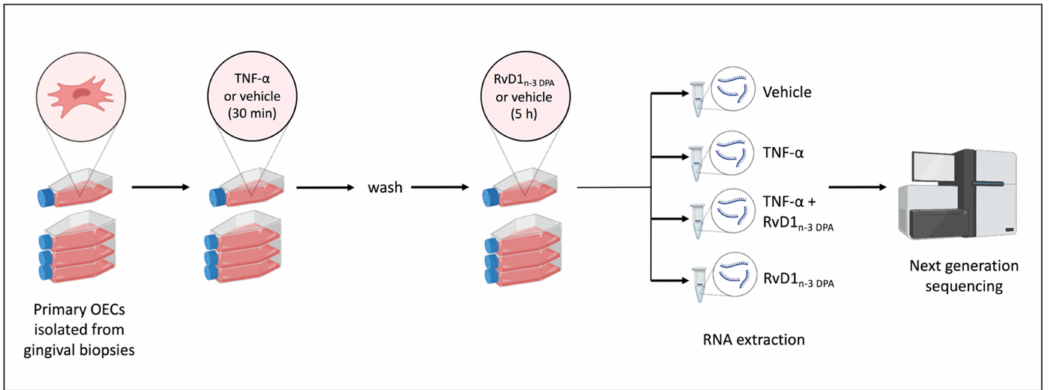
Figure 1. Experimental setup used for mRNA sequencing. Primary oral epithelial cells were incubated for 30 min with TNF- α or vehicle. After washing, RvD1 n-3 DPA or vehicle was added for 5 h. The cells were then harvested and processed for mRNA sequencing. Part of the figure was created with